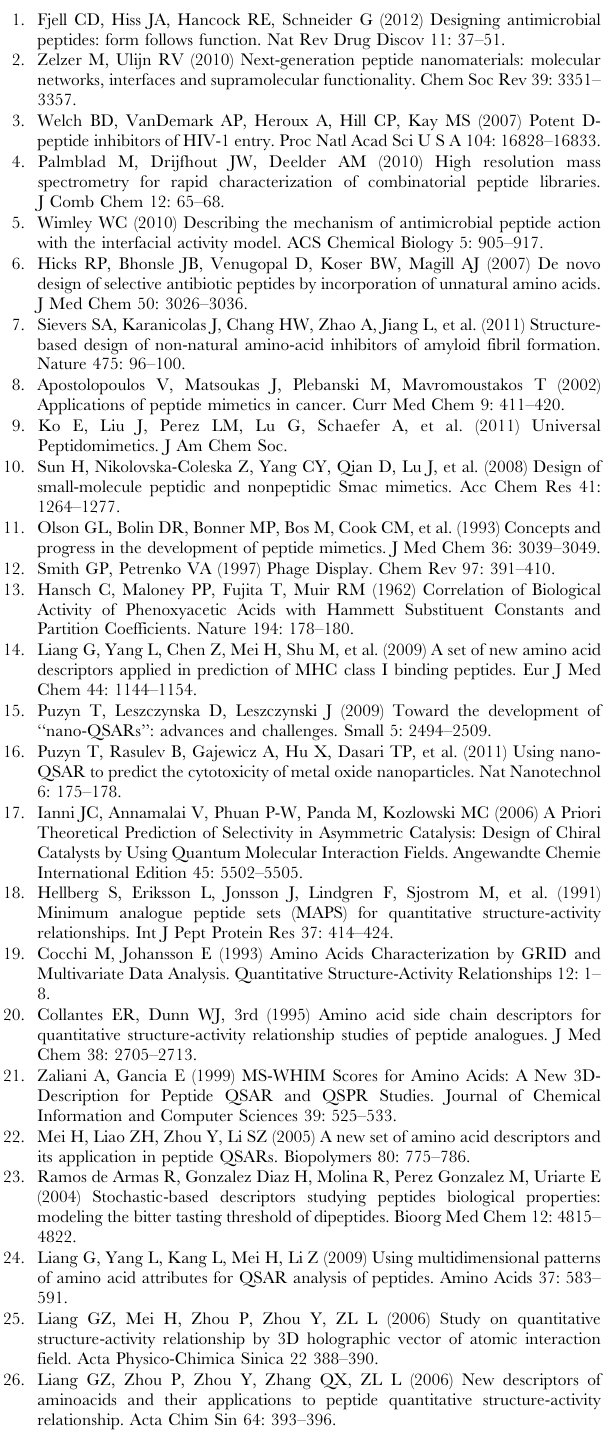
Table S9 Computationally designed mica-binding peptidomi-